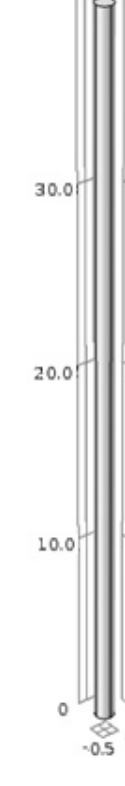
Figure 2. Geometric model of the sensor (dimensions are in mm).